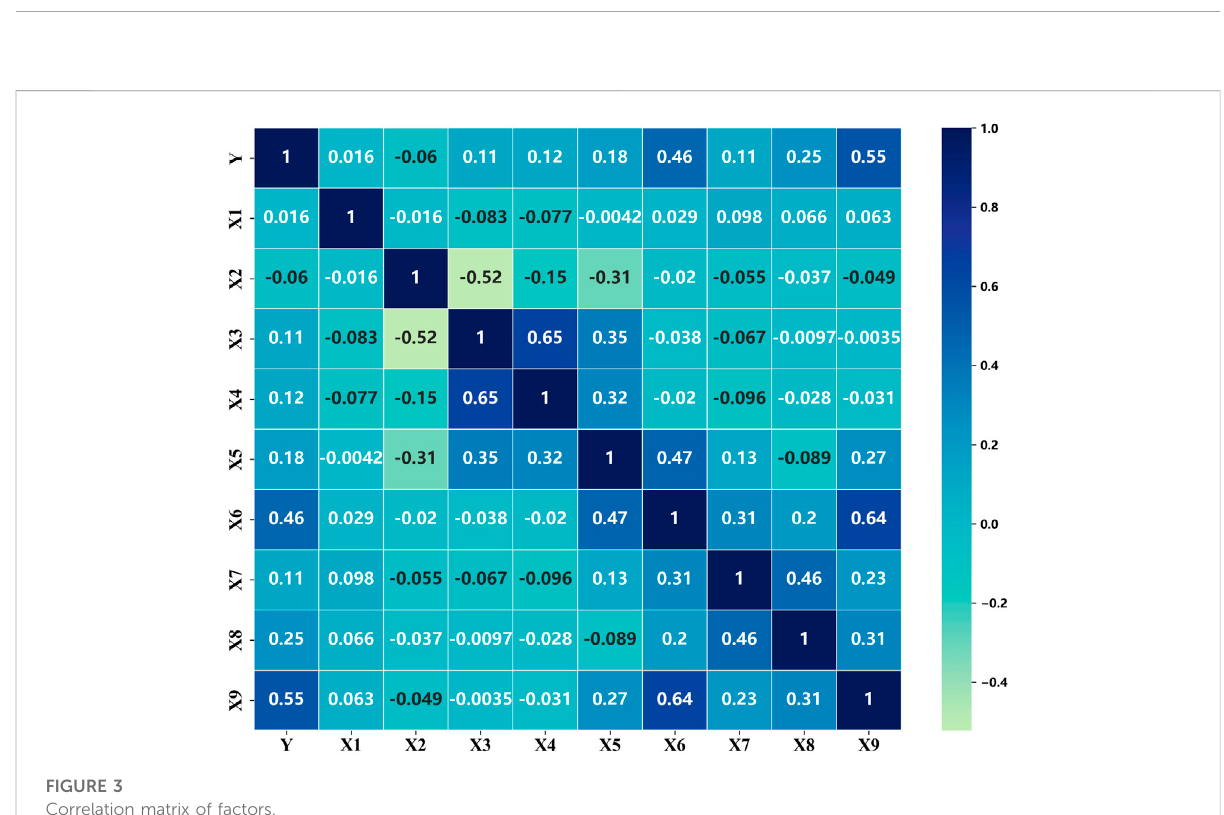
FIGURE 3 Correlation matrix of